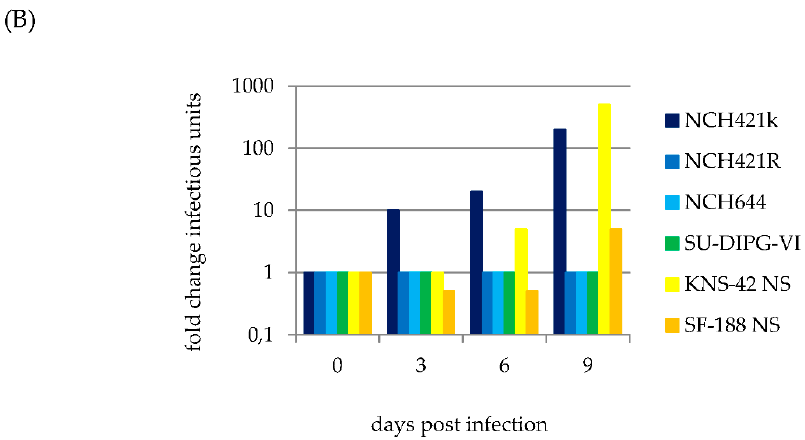
Figure 3. H-1 parvovirus (H-1PV) initiates replication in adult and pediatric HGG neurospheres. Indicated HGG neurosphere cultures were infected with H-1PV (one PFU per cell) six days post seeding. ( A ) Three days post infection, the initiation of virus replication was measured by fluorescence microscopy after cell immuno-staining for the nonstructural viral protein 1 (NS1) ( green ), co-staining of neurospheres with Hoechst 33342 ( blue ) is shown in merge panels; ( B ) H-1PV virus production was assayed in a time course experiment by quantification of infectious particles as described in Section